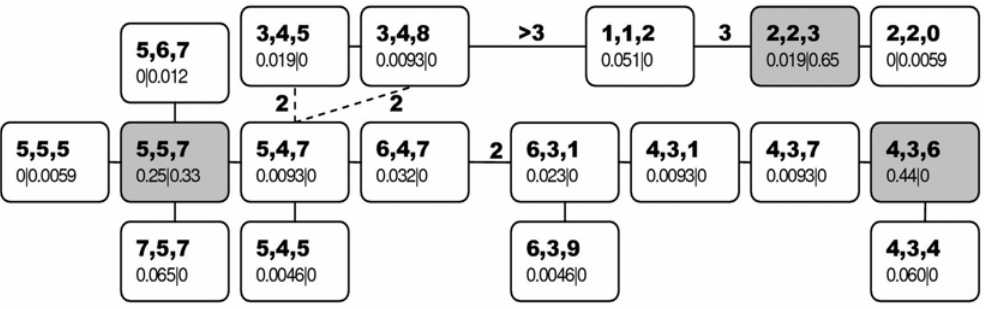
Figure 1. Minimum spanning network of Y chromosomal haplogroups. The minimum spanning network was constructed manually by minimization of the number of (stepwise) mutations between haplotypes with preference given to the mutation of the most polymorphic haplotype when alternative connections were possible. The first row of numbers refers to the different haplotypes at, respectively, microsatellites UMN0304, UMN113, and INRA189. The second row of numbers refers to the haplogroup frequencies in KNP and HiP respectively. The minimum number of mutations is indicated if this is greater than one, roughly corresponding to the length of the connecting line. Grey haplogroups: the three most frequent haplogroups. Dashed lines: alternative connections.